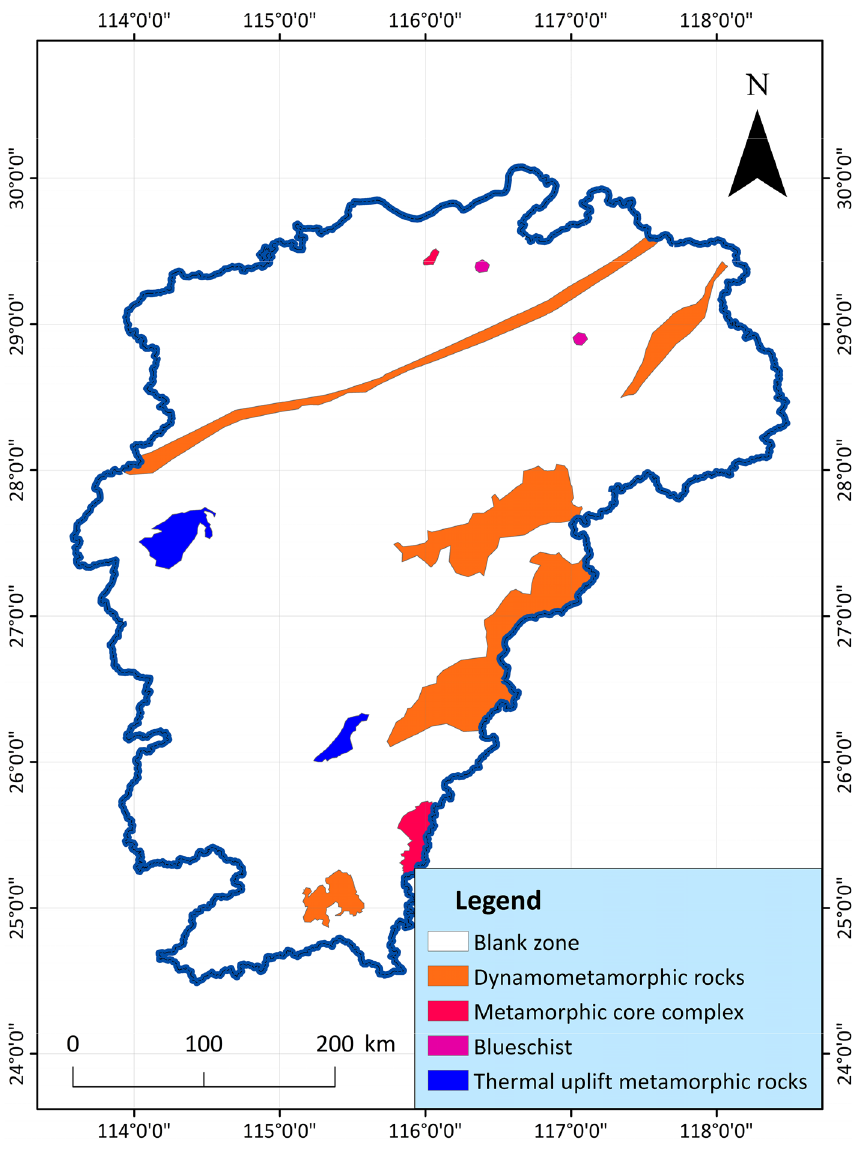
Figure 12. Distribution map of metamorphic rocks in Jiangxi Province 64 .